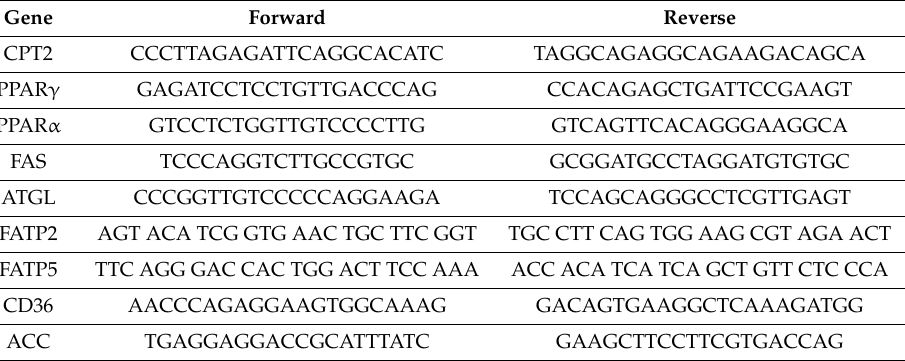
Table 1. Primer sets used in RT–PCR